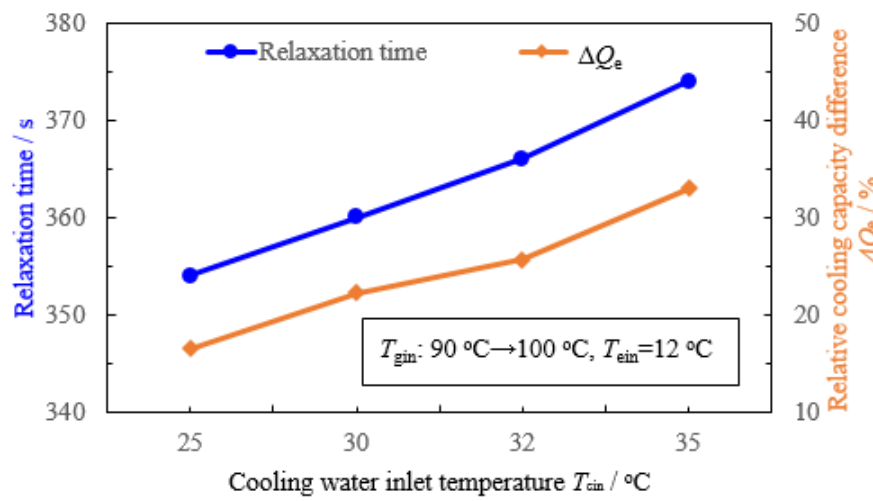
Figure 10. The effect of different T cin on the relaxation time and ∆ Q e .